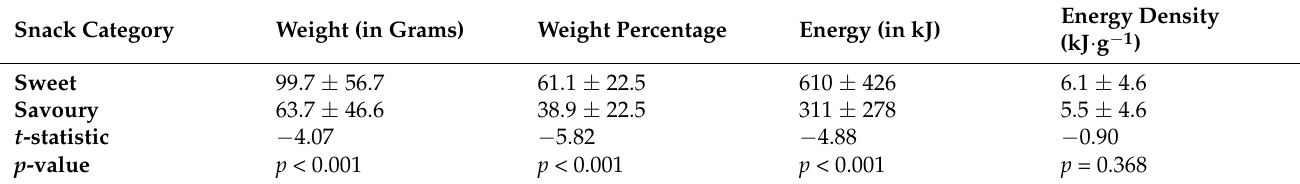
Table 4. Descriptive statistics of average sweet and savoury snack intake data in weight, weight percentage, energy, and energy density measures. Data are reported as mean ± standard deviation.